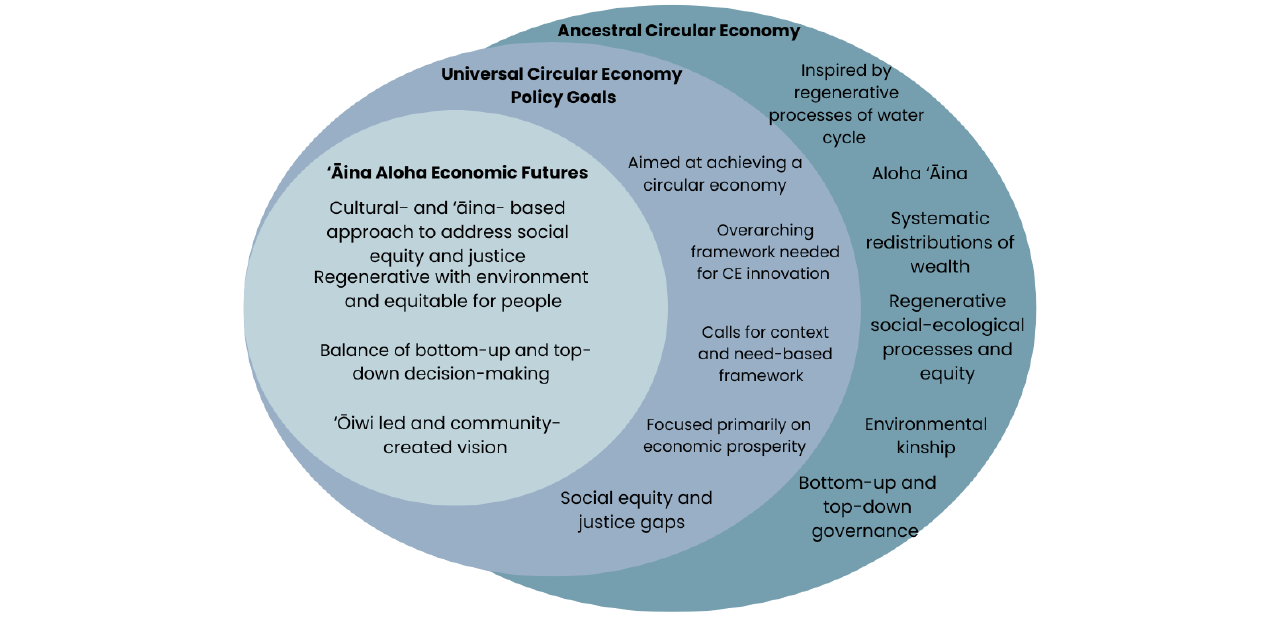
Fig. 1 . Circular economy (CE) policy goal gaps and Indigenous informed